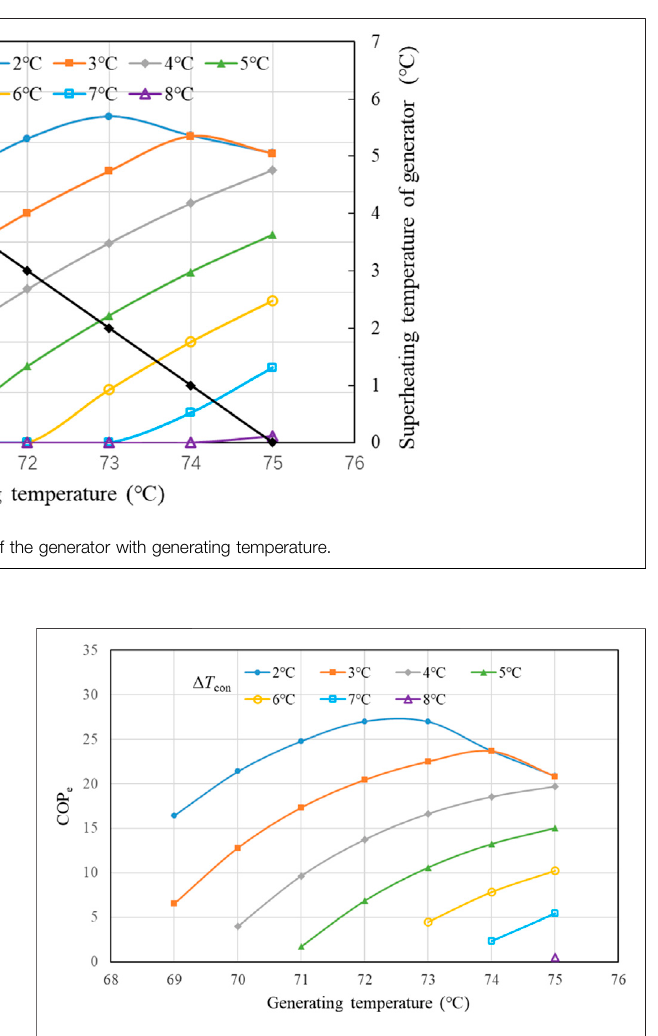
FIGURE5| EffectsofgeneratingtemperatureonelectricityCOP(COP e